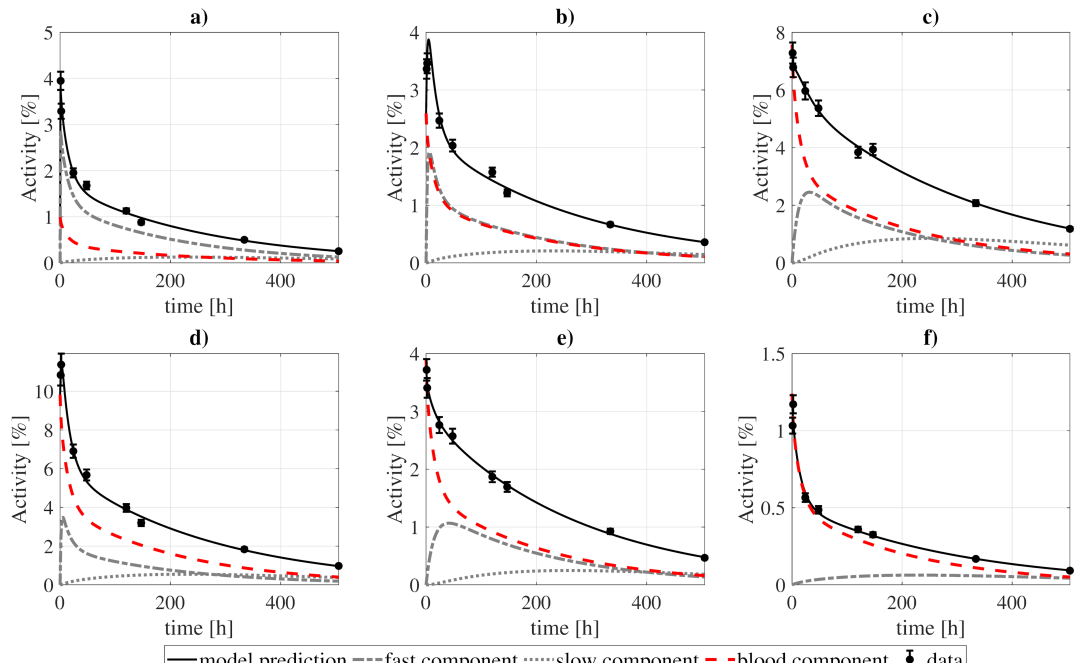
Figure 4. Model fitting to 131 I-CLR1404 biokinetic data for several organs: ( a ) heart wall, ( b ) kidneys, ( c ) lungs, ( d ) liver, ( e ) BM, and ( f ) spleen. The contribution of each compartment (fast, slow, and blood) to organ activities is represented by the dashed lines, while the solid lines show the sum of those contributions. The presented standard deviations were artificially estimated as a 5% of the measurement, as no information regarding uncertainties was reported in the studies of reference. Experimental and modeled activities take into account the physical decay of the 131 I.